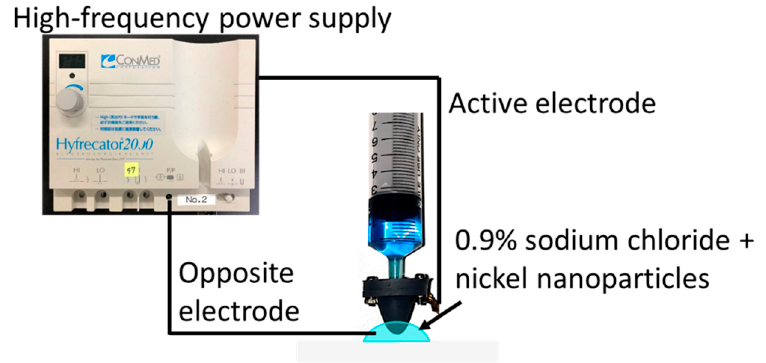
Figure 5. Experimental setup to optimize the distance for the output power. The power supply was connected to the bubble injector and an electric circuit was created through the opposite electrode immersed in the